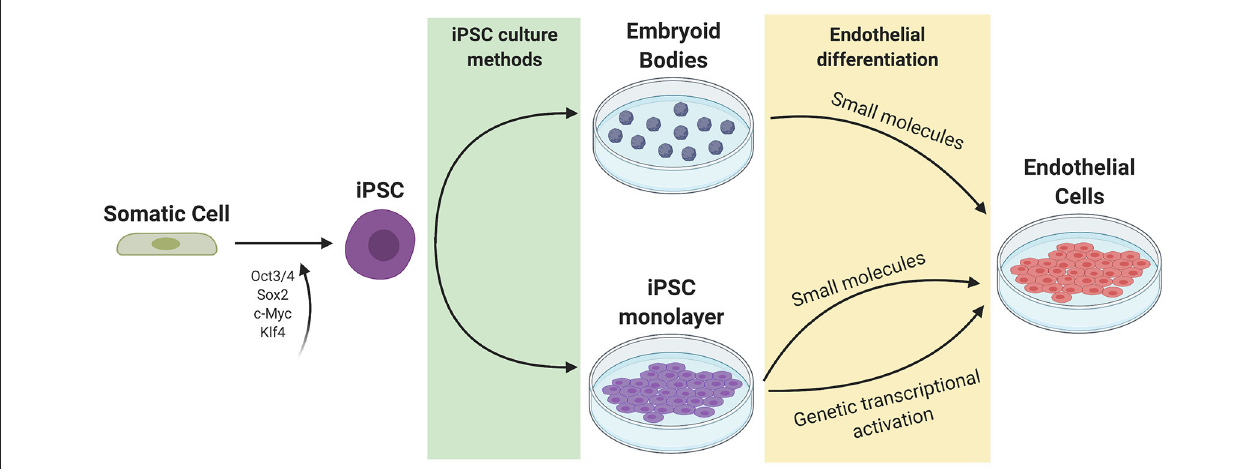
FIGURE 2 | Current methods of iPSC culture and differentiation. Somatic cells are reprogrammed to iPSCs using 4 factors (Oct3/4, Sox2, c-Myc, and Klf4). iPSCs can be cultured as a monolayer or as 3D embryoid bodies. Endothelial differentiation can be achieved through the addition of small molecules to promote mesoderm then endothelial specification, or through genetic transcriptional activation or exogenous addition of